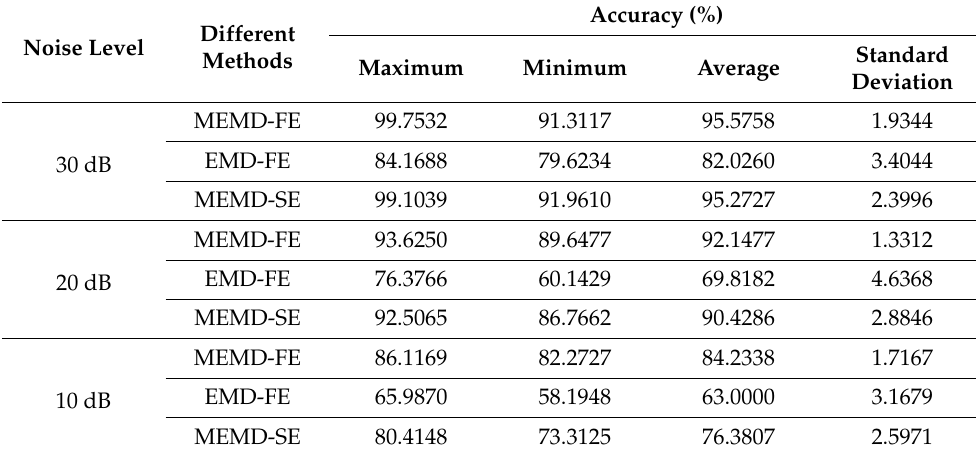
Table 5. Comparison of diagnosis results with different feature extraction